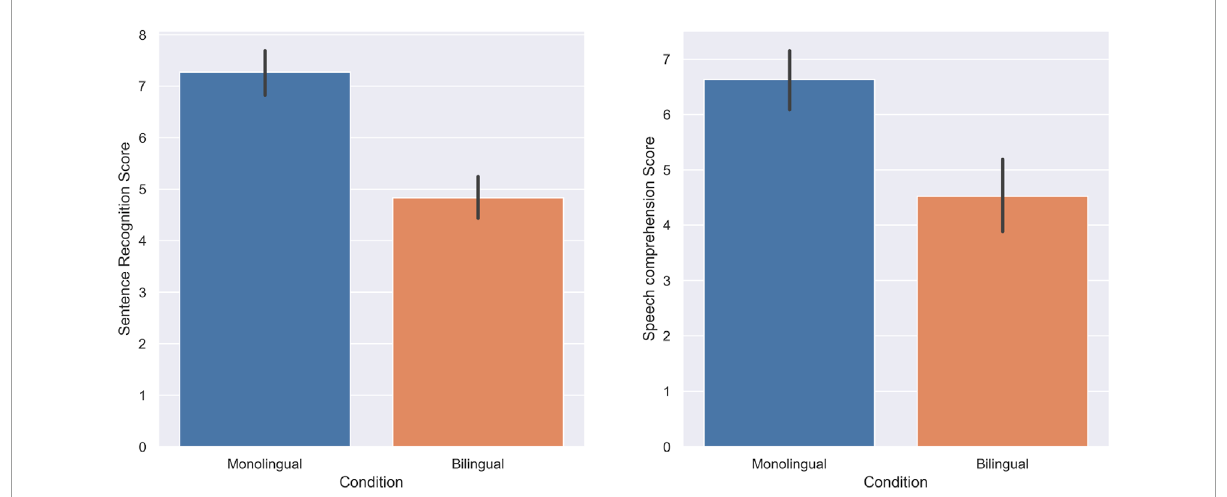
FIGURE 3 Experiment 1: Standard Monolingual and Standard Bilingual. The score of subjects in the Sentence recognition (A) and Speech comprehension (B) tasks.